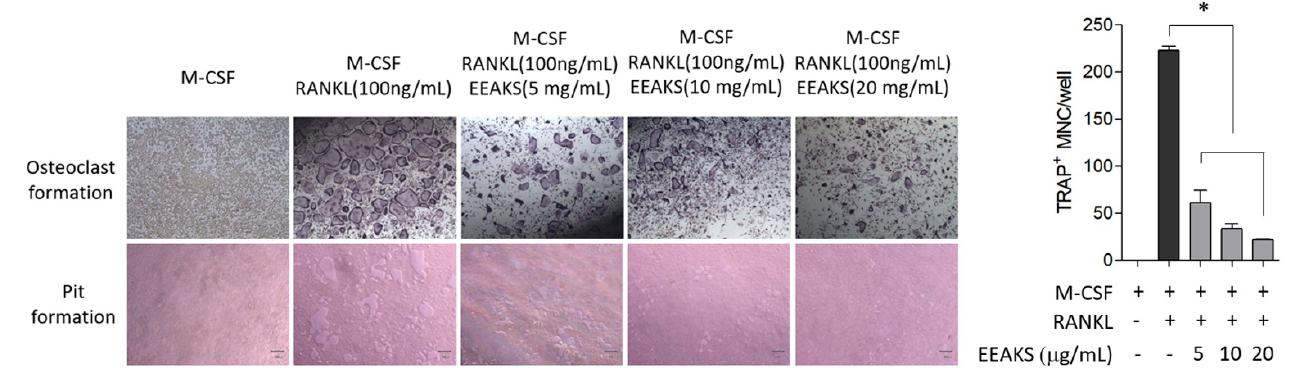
Figure 4. Effect of EEAKSs on RANKL-induced osteoclastic bone resorption. Mouse BMM cells were treated with M-CSF (30 ng/mL) and RANKL (100 ng/mL) with or without EEAKSs (5 or 10 µ g/mL) and were stained to detect the expression of TRAP. Resorptive pit was also detected on calcium phosphate apatite-coated plates under light microscopy. The total number of TRAP-positive multi- nucleated ( ≥ 3 nuclei) osteoclasts (MNCs) per well is graphically presented. The data are expressed as the mean ± standard error of the mean (SEM). * p < 0.001 vs. M-CSF+RANKL condition. (+), add; (-), no add.